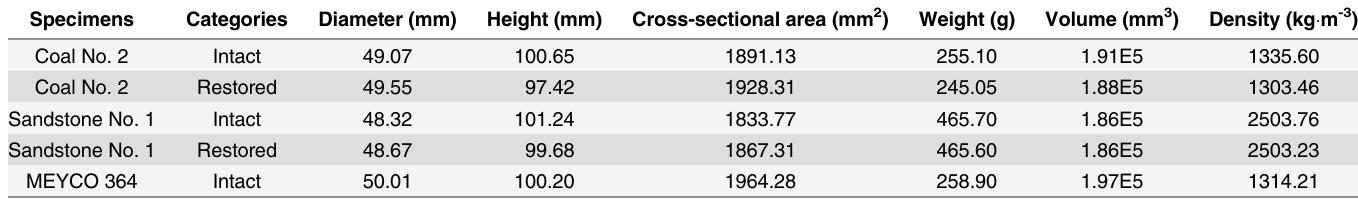
Table 1. Physical and mechanical properties of the test samples.